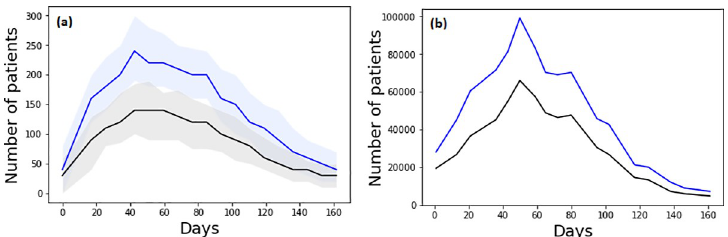
Fig 1. A comparison of AV treatment collection rates relative to ILI consultations (based on NPFS authorisations) between the model output and empirical data from 2009. For the model output, the solid lines represent the mean model outputs and the shaded regions represent the range of the middle 80% of model output over 1,000 iterations.